Question: Which kind of chart has been used to present this data?
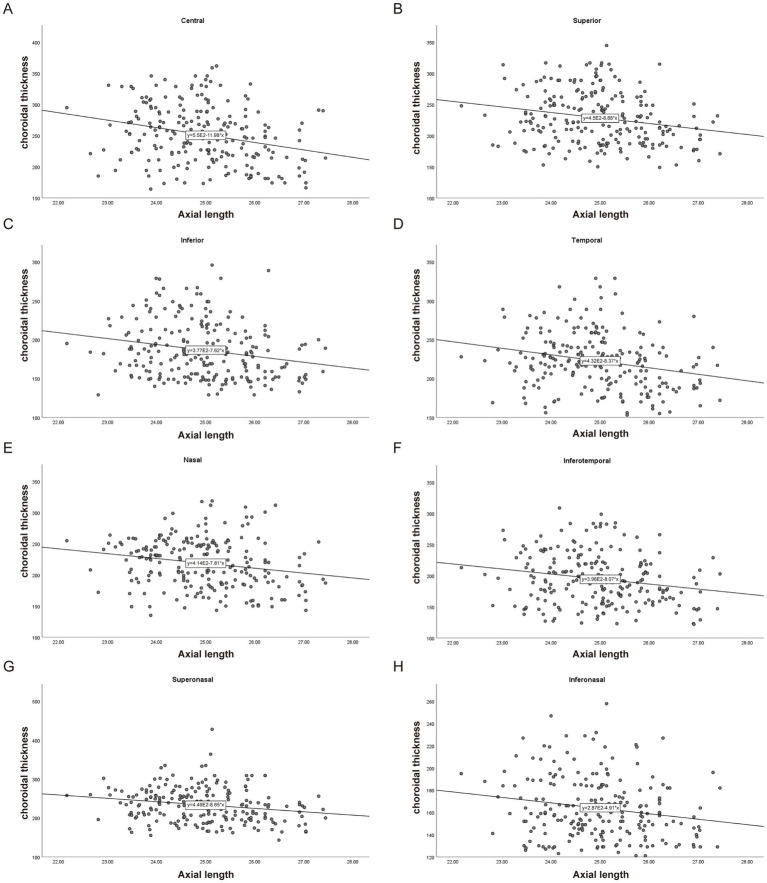
Answer: scatter